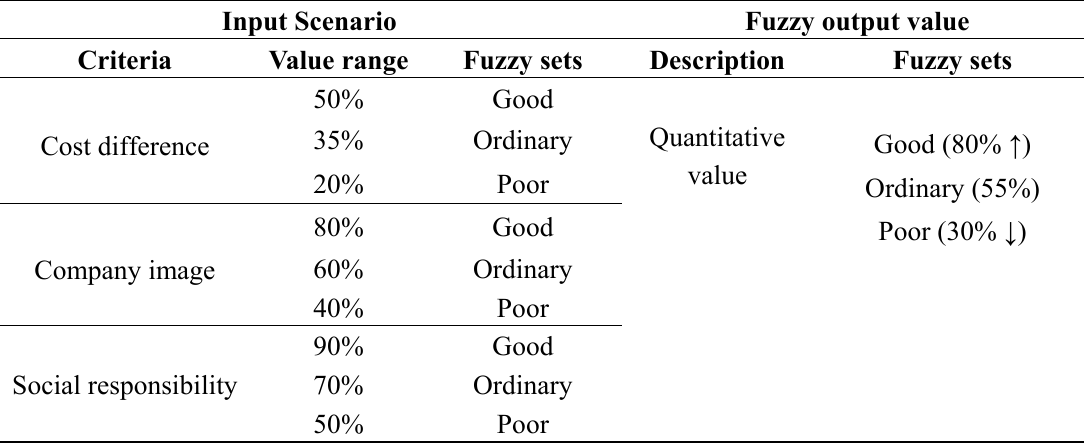
Table 8. Definition of the input and output fuzzy set and fuzzy range for the green attractions